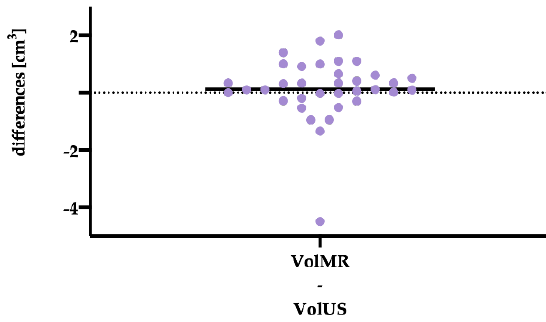
Figure 2. Scatter plot of the di ff erences of volumes in MRI (VolMR) and US (VolUS). The line indicates the median di ff